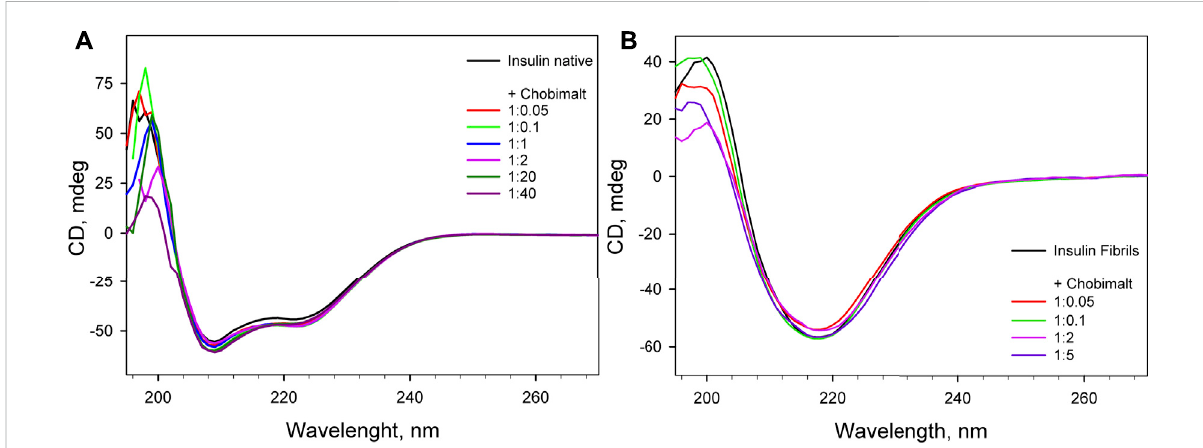
FIGURE 4 Far UV- circular dichroism spectra of native insulin in the absence and presence of different concentrations of Chobimalt (A) , and insulin amyloid fi brils formed in the absence and presence of different concentrations of Chobimalt (B) . Concentration of insulin was always 25 µM. The spectra were taken immediately after the detergent was added to protein (A) and after of the fi brillization process (B)